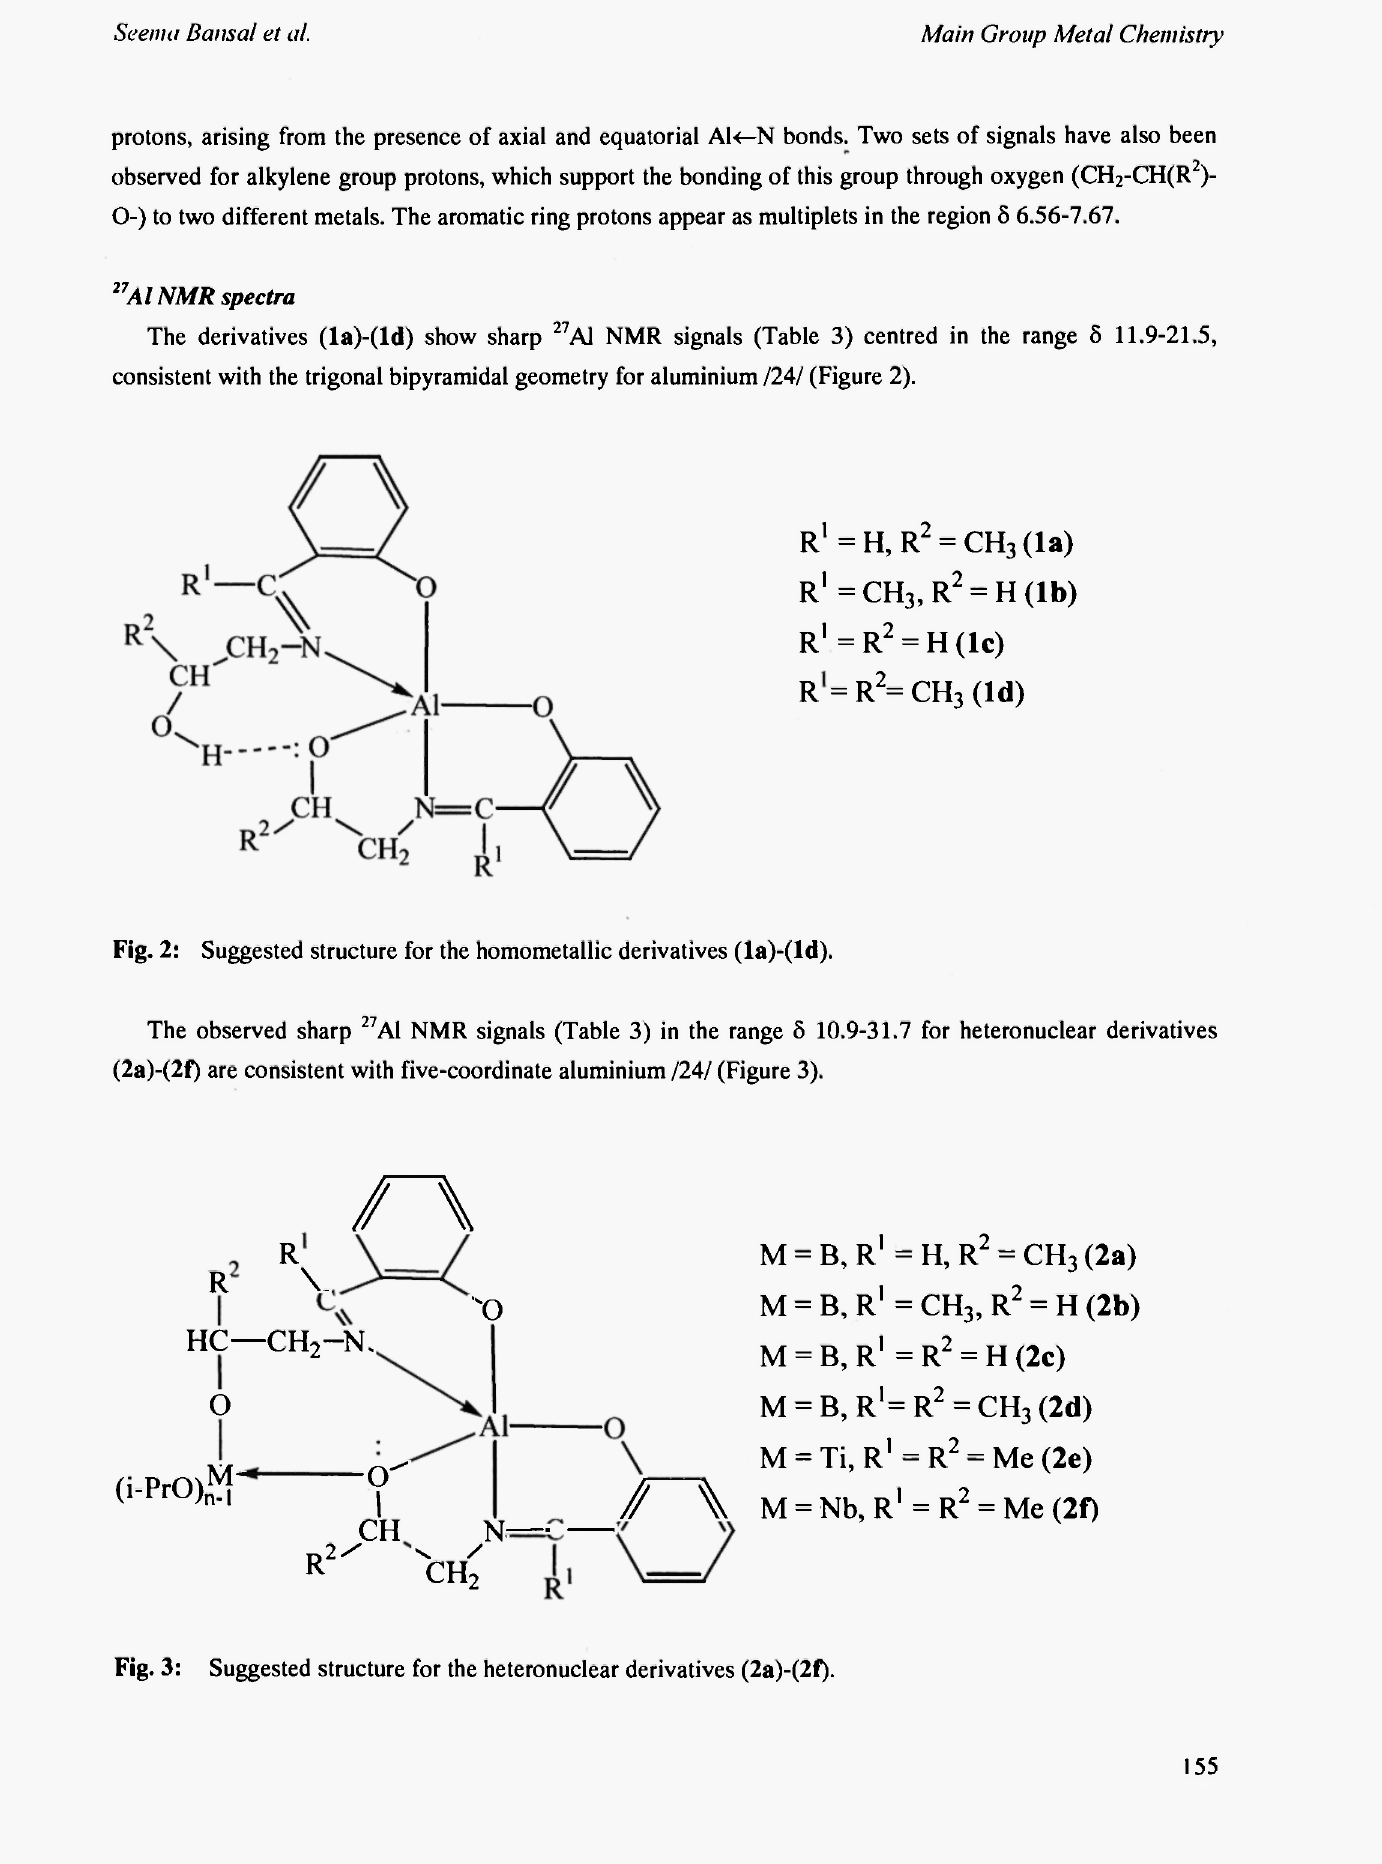
Fig. 3: Suggested structure for the heteronuclear derivatives